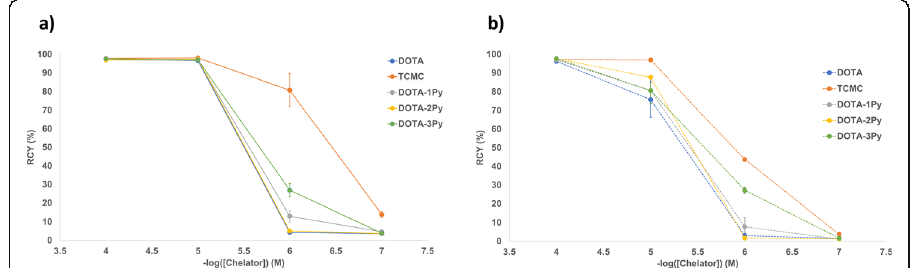
Fig. 7 Radiochemical yield (RCY, %) for a 212 Pb and b 203 Pb radiolabeling reactions at pH 7 and room